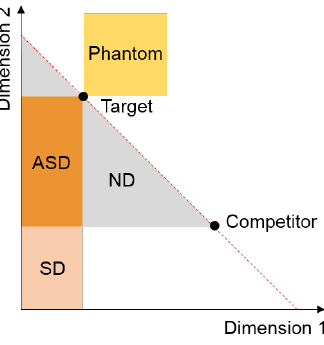
Figure 2. Locations of the two alternatives and